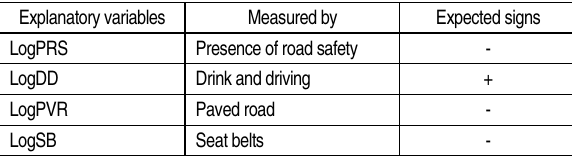
Table 2. Summary of expected